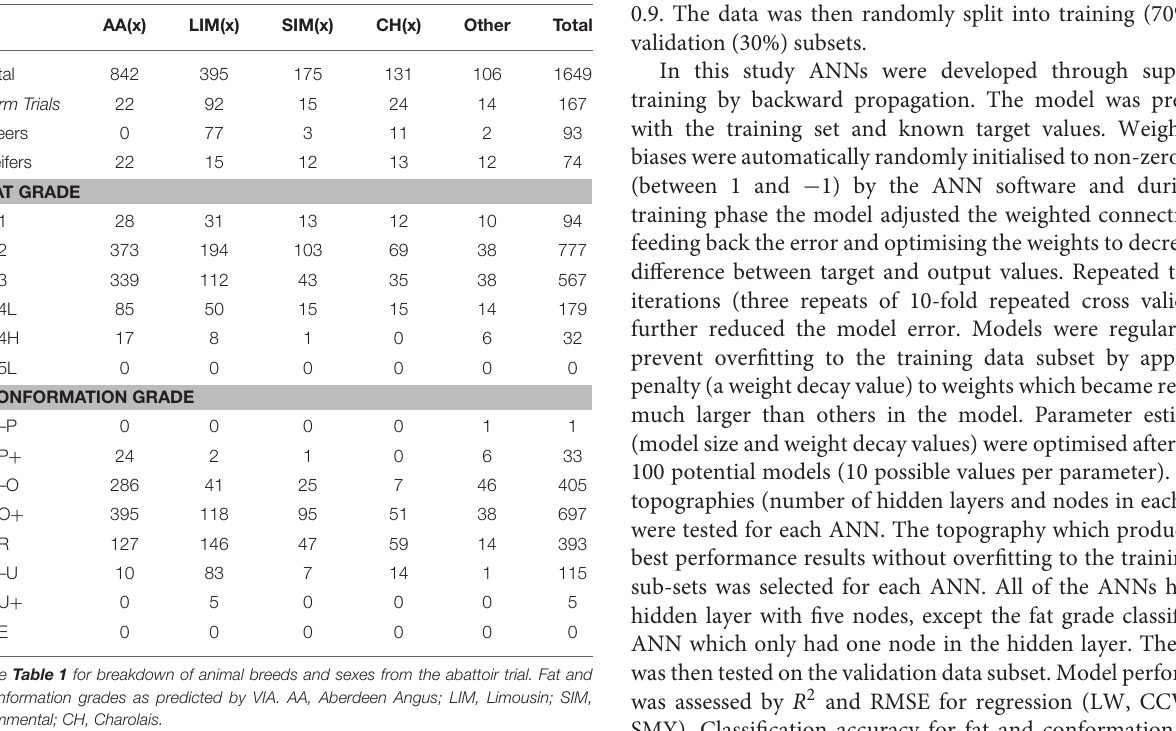
transformation (subtracting the mean and dividing by one TABLE 2 | Summary of cattle used in the development of carcass characteristics prediction algorithms. standard deviation) and min-max scaling between − 0.9 and 0.9. The data was then randomly split into training (70%) and SIM(x) CH(x) Other Total validation (30%)